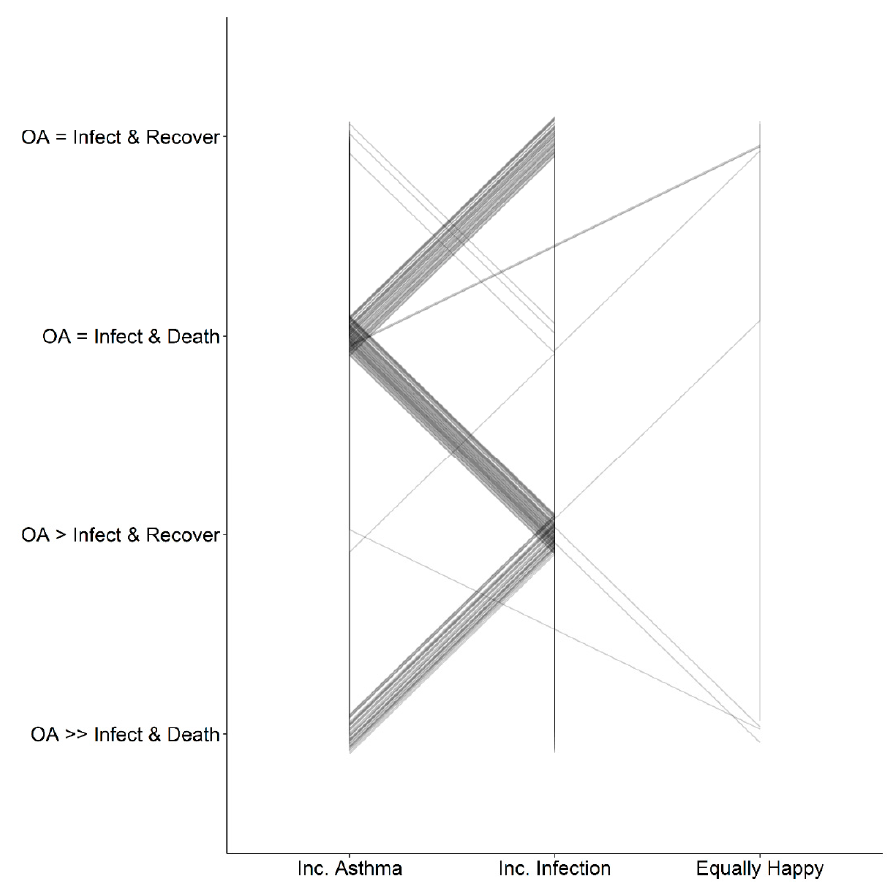
Figure 2. Preference choice ( x axis) of either increased asthma risk to maintain infection risk (inc. asthma), increased infection risk to maintain asthma risk (inc. infection), or being equally happy with either increase, per individual for each scenario (in chronological order of the survey from top to bottom on the left axis). Scenarios are described based on baseline risks, either equal or unequal risks of occupational asthma (OA) and infection and recovery (infect and recover) or infection and death (infect and death).